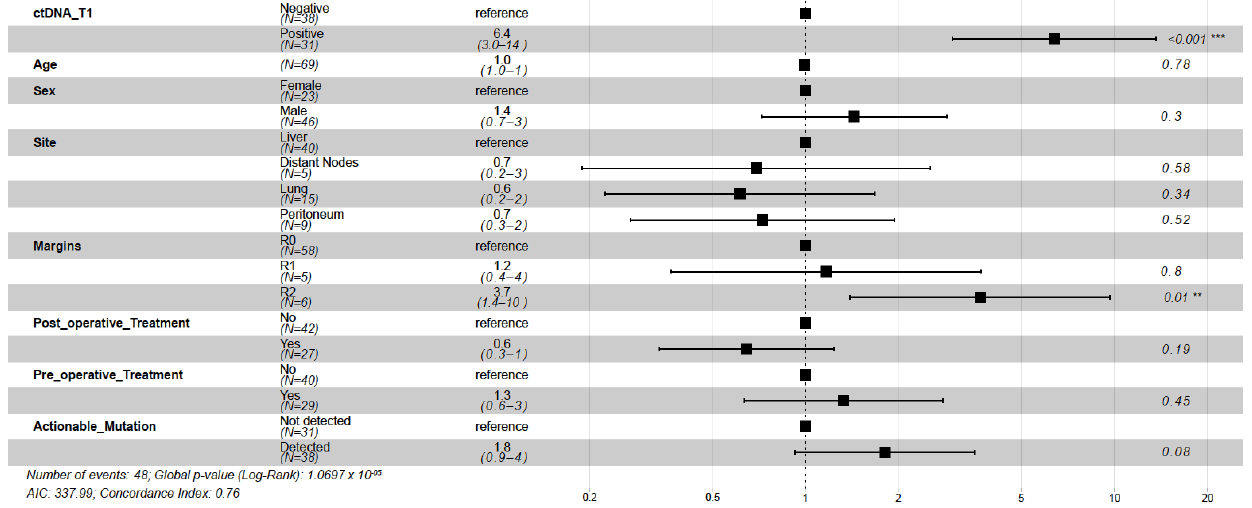
Figure 5. Forest plot depicting the multivariate analysis of prognostic factors and their association with DFS, as indicated by the Hazard Ratio. R2 resection margin had a significant association with disease-free survival ( p = 0.008). ctDNA detection at the postsurgical time point (T1) was the most